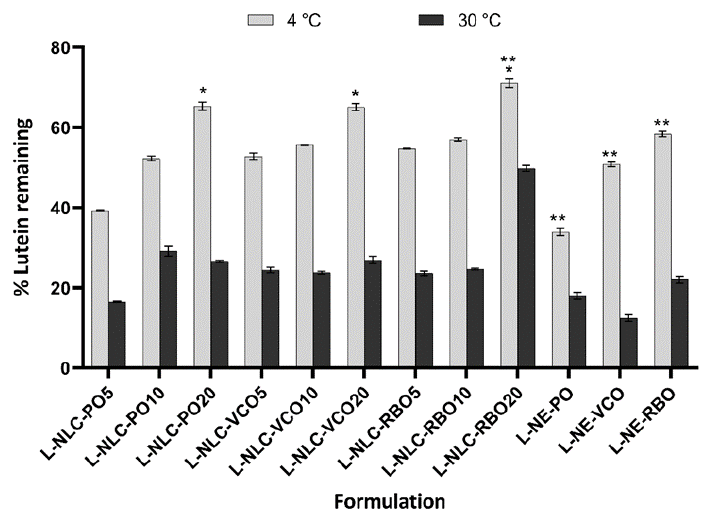
Figure 5. The % lutein remaining after being stored for 3 months at 4 ◦ C and 30 ◦ C ( n = 3). * Statistically significant difference among all L-NLC formulations that contained the same type of oil ( p < 0.05). ** Statistically significant difference comparing the % of lutein remaining among all L-NLC and L-NE formulations that contained the same concentration of oil ( p < 0.05).